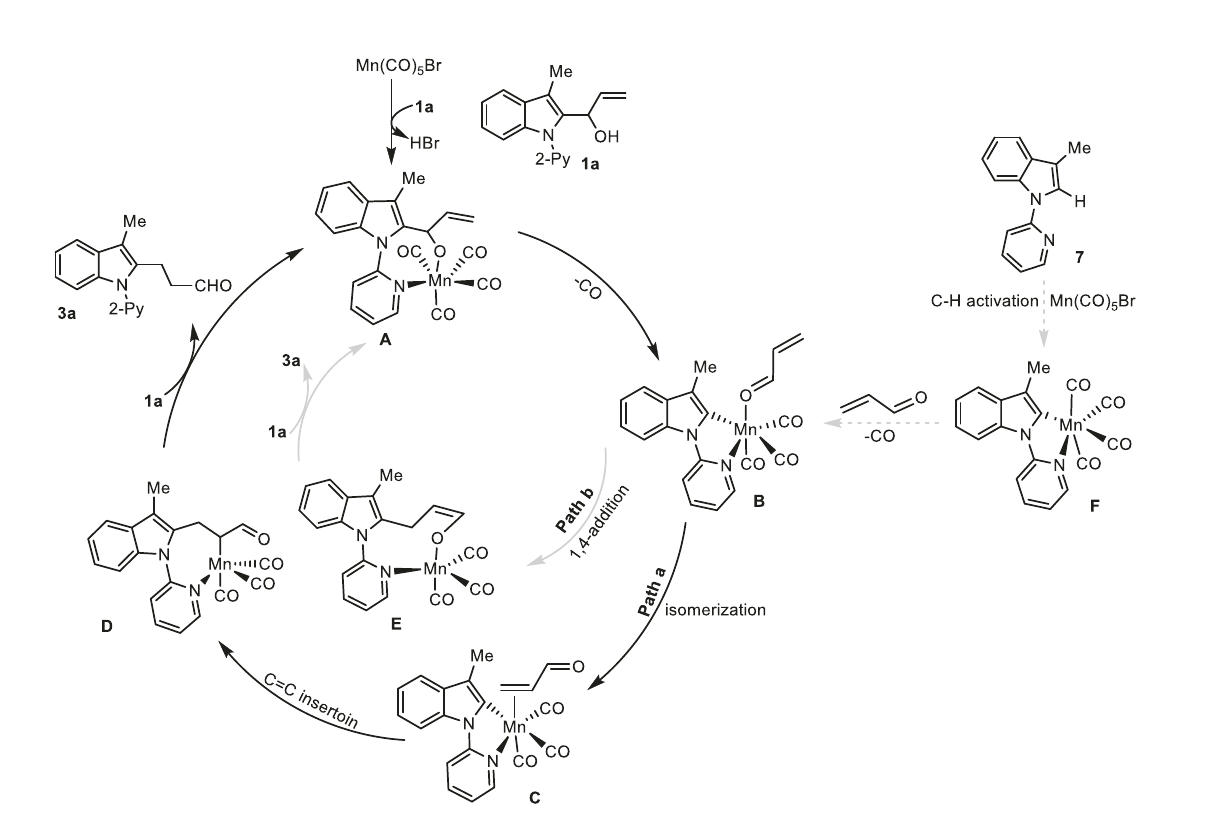
Fig. 7 | Proposed reaction mechanism. Path a Mn(I)-catalyzed 1,3-STR via intramolecular ligand exchange and migratory insertion. Path b Mn(I)-catalyzed 1,3-STR via intramolecular